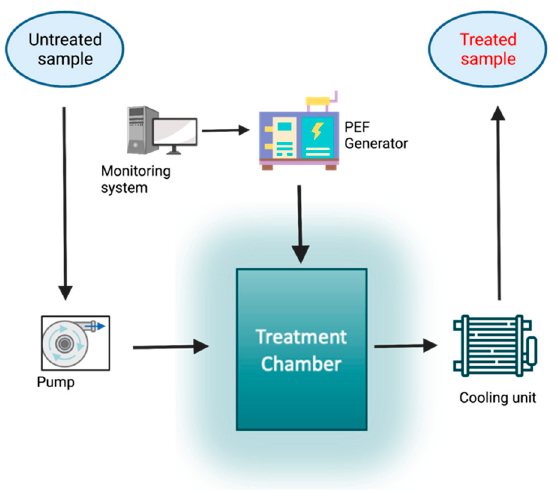
Figure 4. Schematic representation of a pulsed electric field unit (adapted from [63,64]; created with BioRender.com, accessed on 2 January 2023).